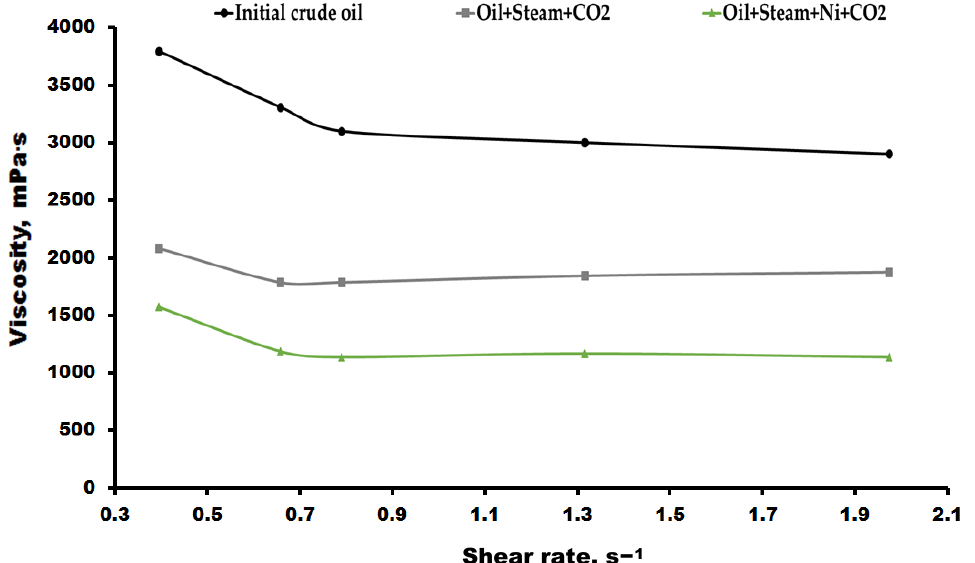
Figure 9. Shear rate-dependent viscosity values, before and after noncatalytic and catalytic CO 2 - assisted hydrothermal upgrading.